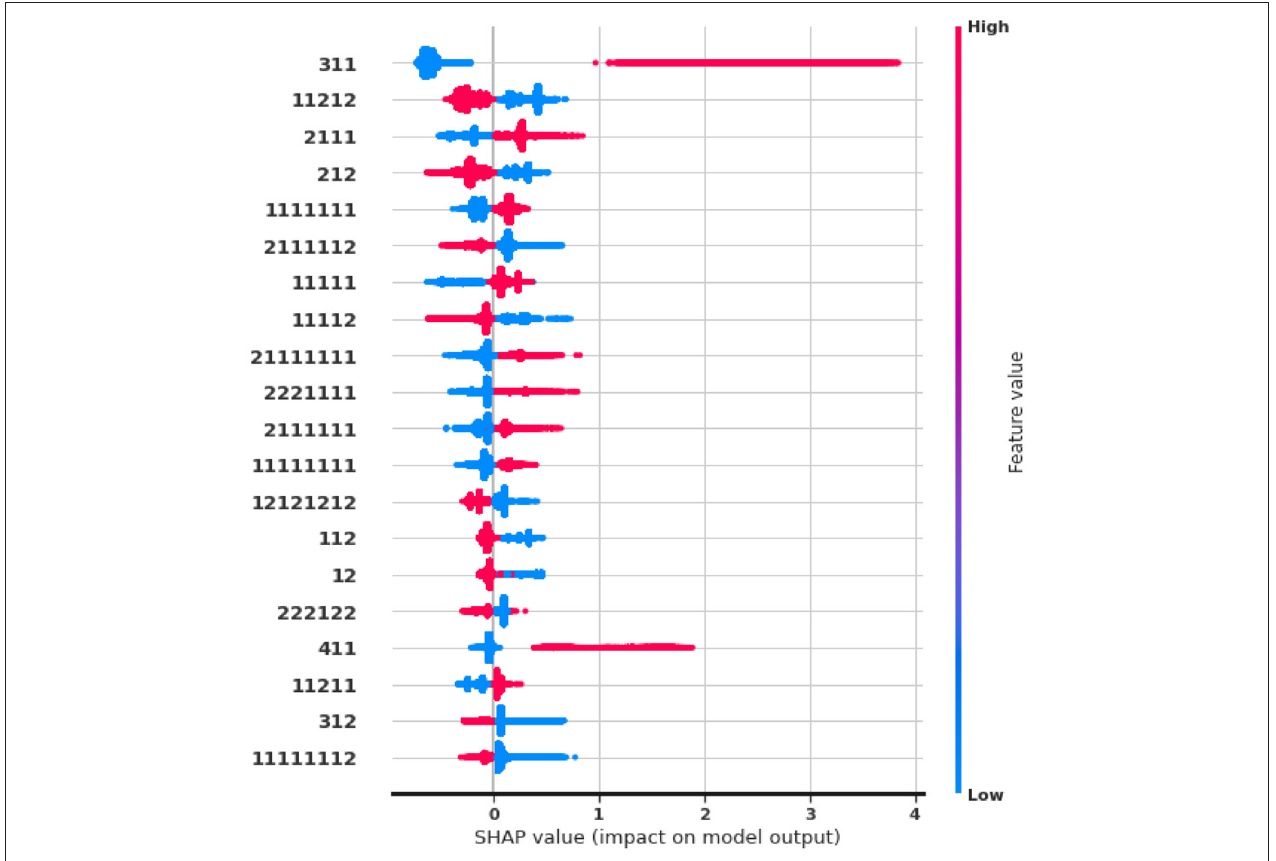
FIGURE 5 | SHAP values of auto-generated Seq2Pat features. Top-20 features ranked in descending importance. Color indicates high (in red) or low (in blue) feature value. Horizontal location indicates the correlation of the feature value to a high or low model